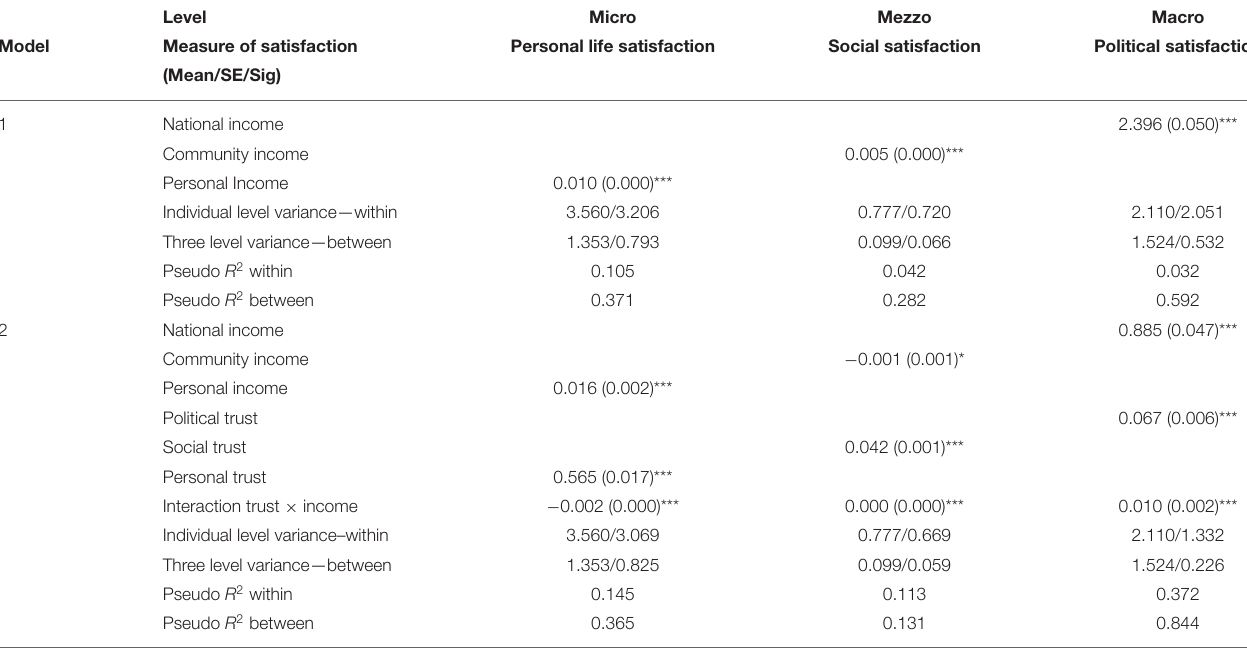
TABLE 2 | Results [Beta (SE)] of multilevel analysis of personal life satisfaction (micro level), social satisfaction (mezzo level) and political satisfaction (macro level).